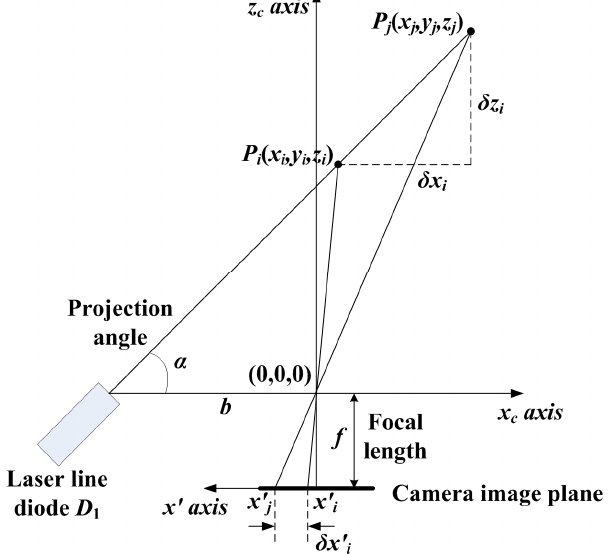
, and analysis of their 1